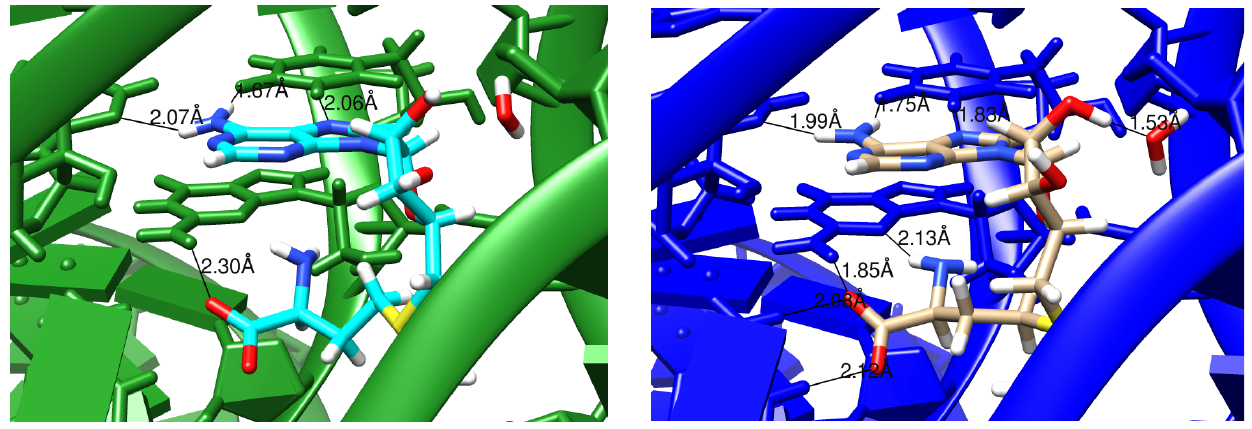
Figure 4. Images comparing conventionally and AMBER-restrained (green and blue, respectively) refinement outputs for 2gis [29]. Hydrogen bonds indentified by the cpptraj module in AmberTools are marked with the distances involved. The ligand being examined is S-adenosylmethionie